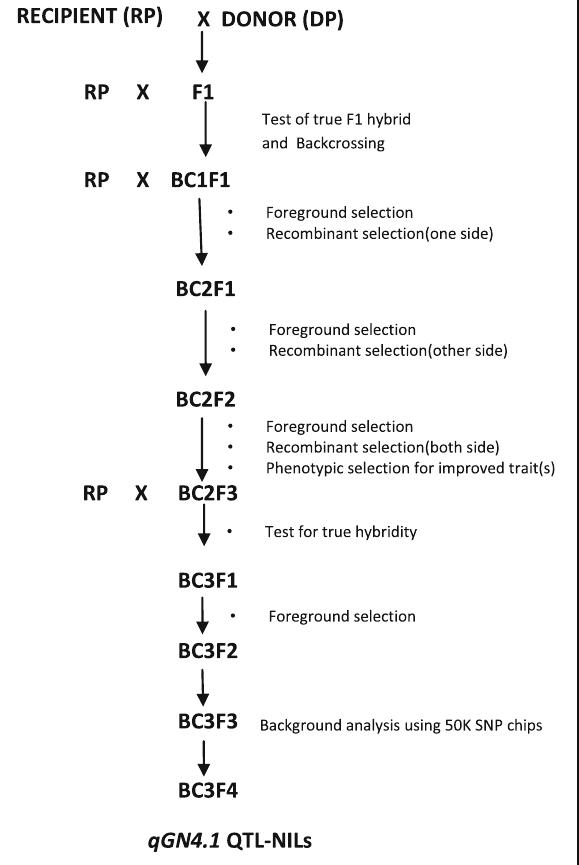
Fig. 1 Crossing and selection scheme for the transfer of high grain number QTL qGN4.1 in to popular high yielding mega varieties of